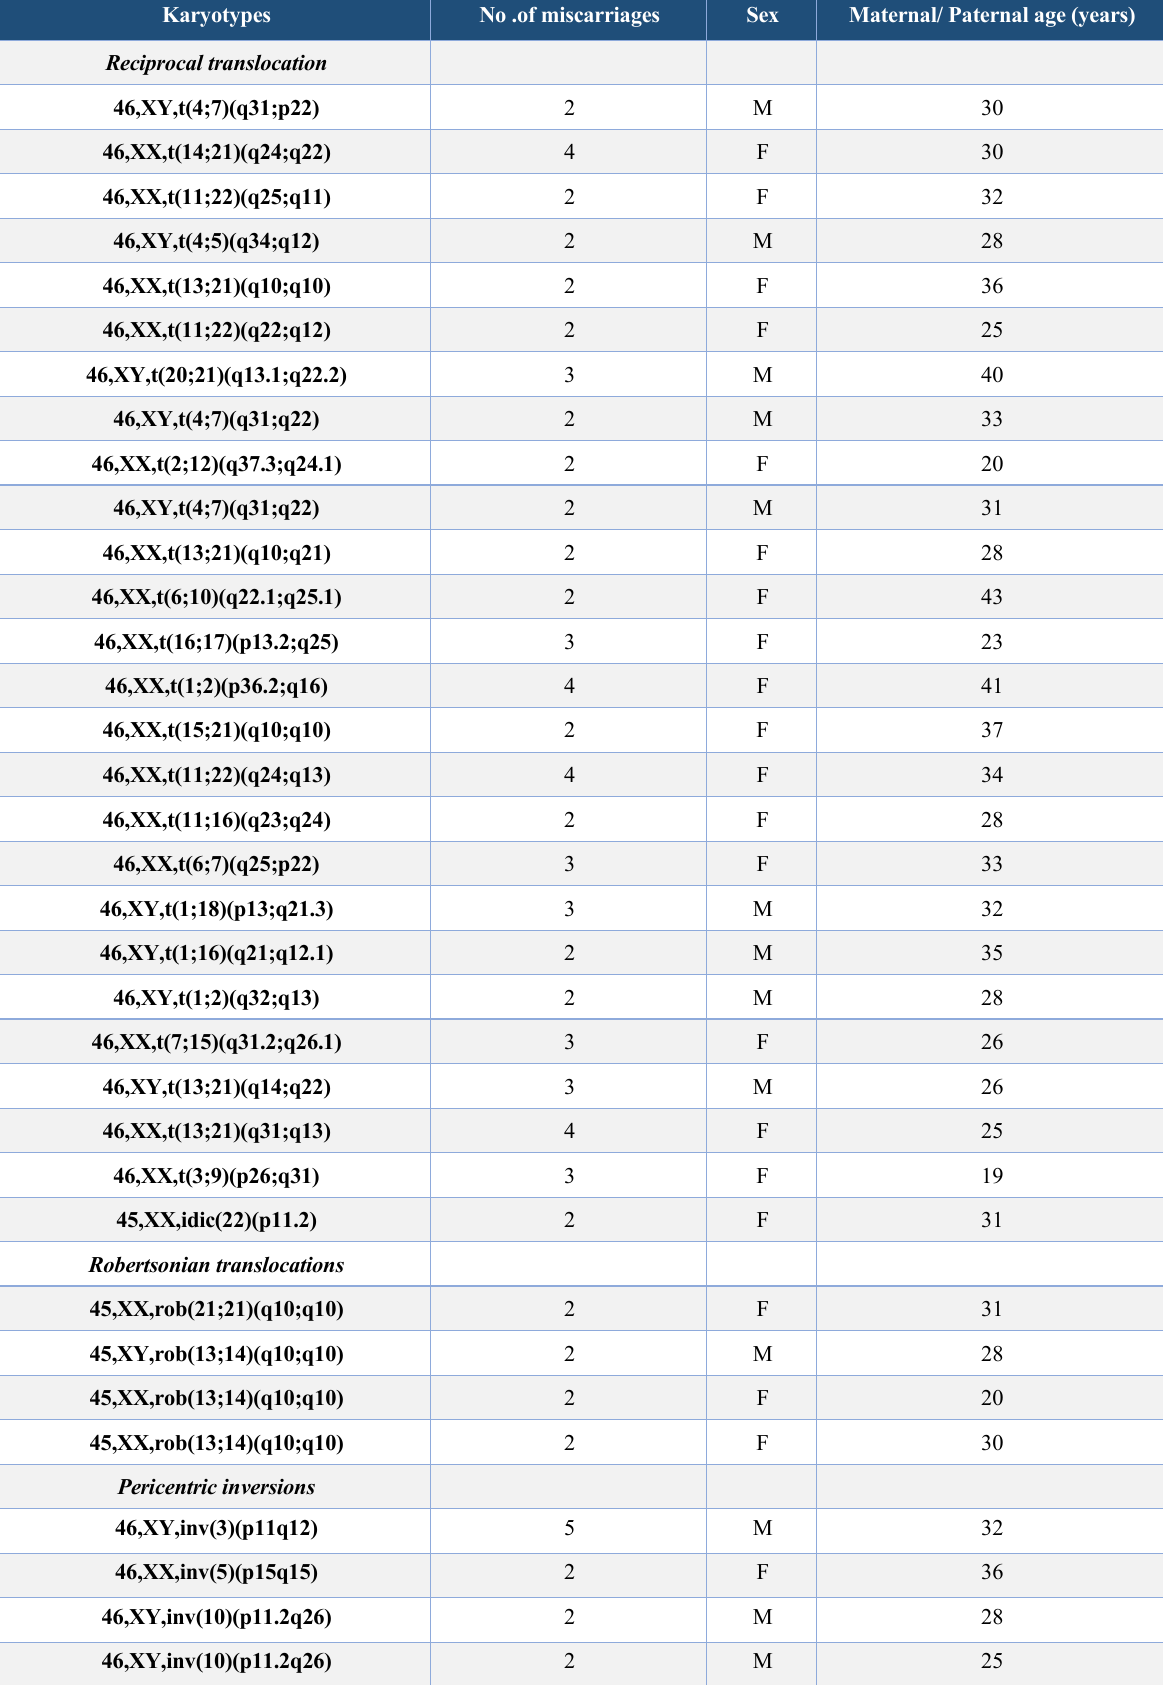
Table 2. Cytogenetic findings, number of miscarriages and maternal/paternal age in recurrent miscarriage cases with structural